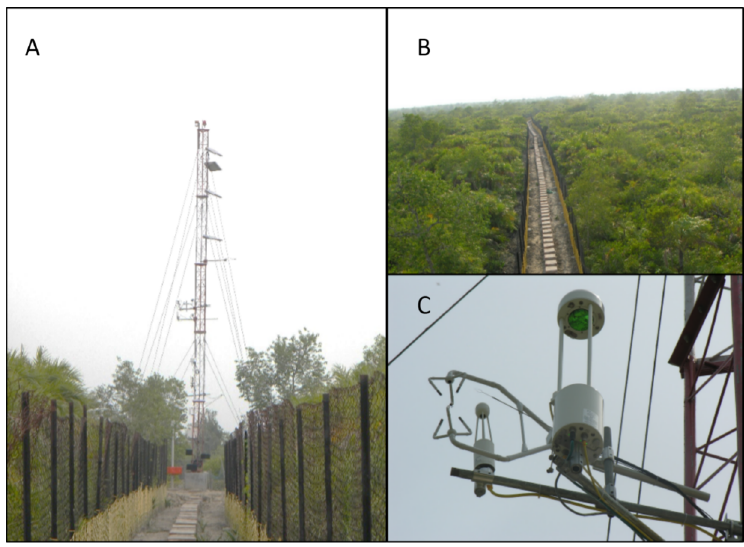
Figure 2. ( A ) Sundarbans flux tower; ( B ) Canopy walkway; ( C ) CO 2 and H 2 OIRGA (LI-7500A), Methane IRGA (LI-7700) and 3D sonic anemometer (CSAT-3) mounted on the flux tower. Micrometeorological and trace gas (CO 2 ) measurements were made at a height of 10